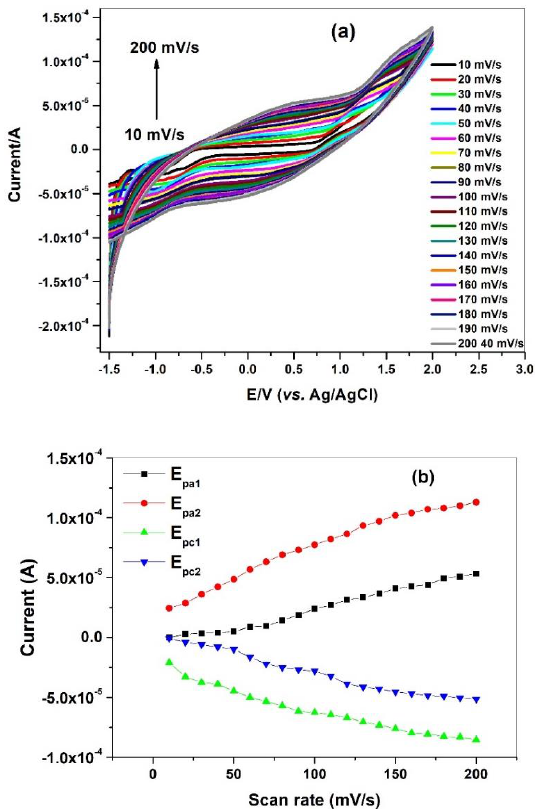
Figure 7. ( a ) Effect of the scan rate using a wide scan range, from 10 to 200 mV/s , ( b ) Effect of scan rate on the anodic and cathodic peak currents for compound 4. rate on the anodic and cathodic peak currents for compound 4